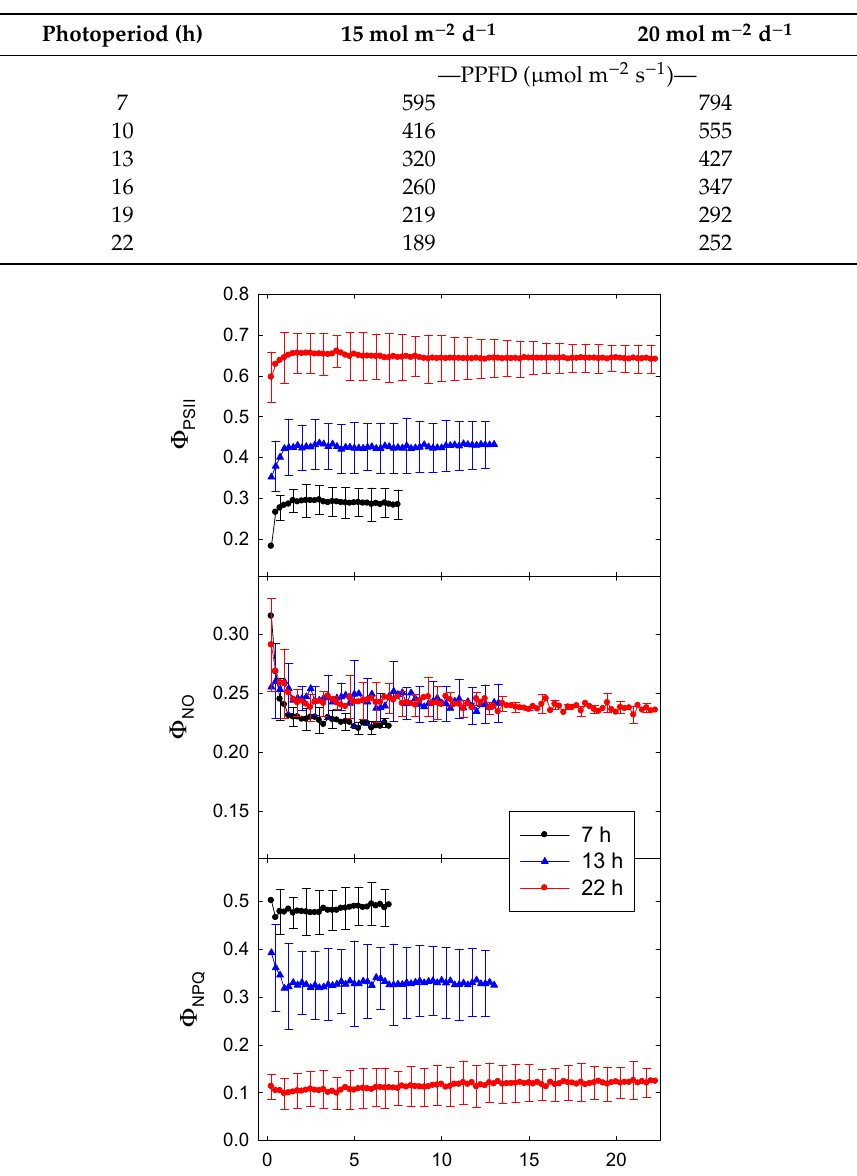
Table 1. Photosynthetic photon flux density (PPFD) during photochemical measurements. Plants were measured during photoperiods ranging from 7 to 22 h and PPFD was adjusted to ensure a daily light integral (DLI) of 15 or 20 mol m − 2 d − 1 .